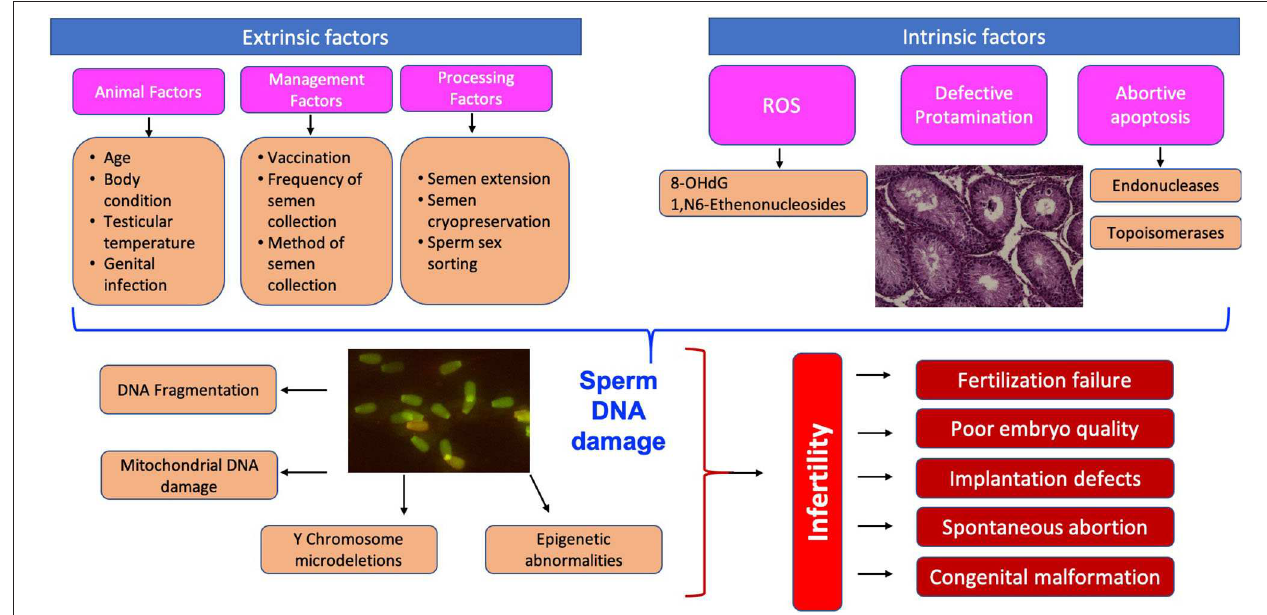
FIGURE 1 | Schematic representation of the causes and consequences of sperm DNA